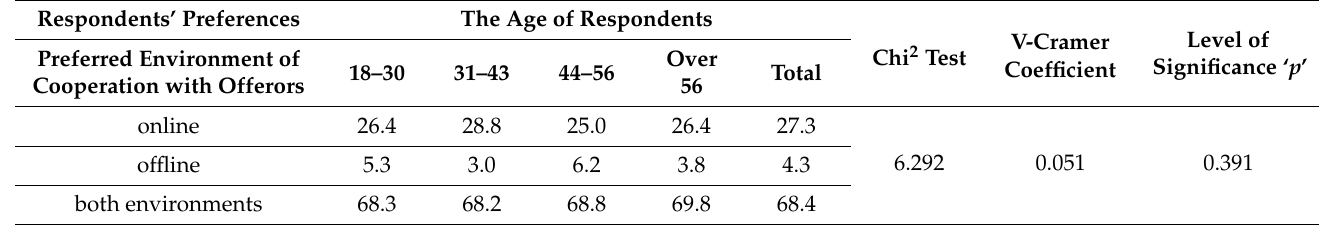
Table 6. The age of respondents compared with the preferred environment of cooperation with offerors and the benefits of cooperation with offerors indicated by respondents as more important.